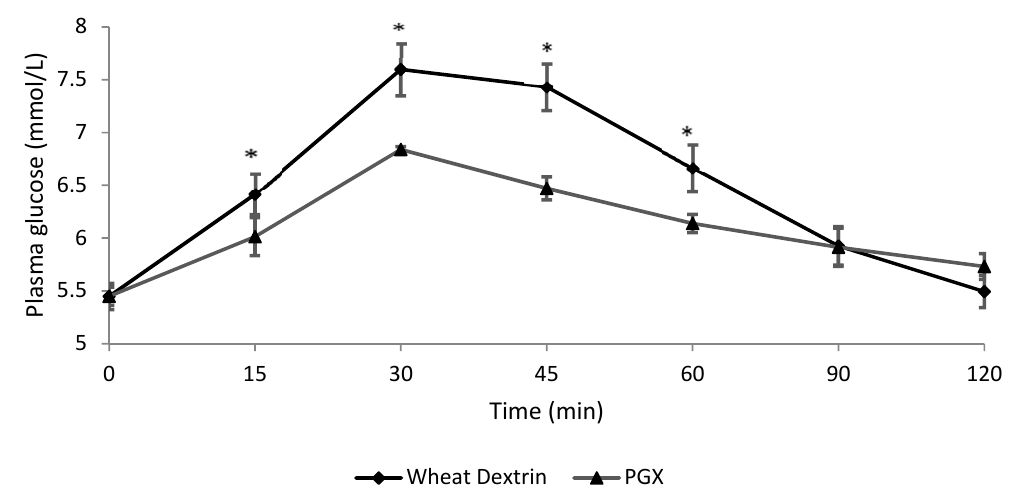
Figure 3. Comparison of postprandial blood glucose response (mean ± SEM) over time by treatment group for wheat dextrin (control) and PGX (granules). * PGX plasma glucose level was significantly different to that of WD ( p < 0.05).